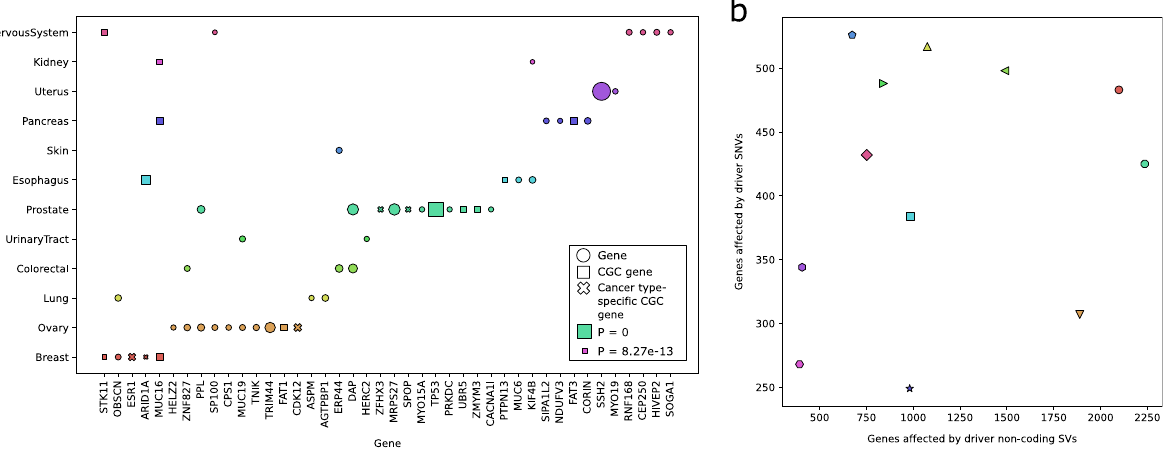
Figure 2. Analysis of predicted pathogenic non-coding SV pairs. (a) Genes affected by pathogenic non-coding SVs as identified by svMIL2 with significant driver potential (showing top 50 most significant gene-cancer type pairs). To determine significant driver potential, random gene sets were sampled 10,000 times with the same size as the number of genes with candidate pathogenic non-coding SVs. A t-test was used to compute which of the candidate genes have more driver coding SNVs (snpEff moderate or high impact, filtered for consensus genes driven by SNVs from IntOGen) than expected by random chance. (b) Comparison of the number of genes affected by pathogenic non-coding SVs with the number of genes affected by driver SNVs reveals a preference for a different driving mechanism per cancer The number of pathogenic non‑coding SVs varies between cancer types. The highest number of pathogenic non-coding SVs is detected in breast, ovarian and prostate cancer, while only low numbers are identified in uterus and kidney cancer (Fig S4c, Table S2). Although the number of pathogenic non-coding SVs increases with the total number of SVs detected within a cancer type, uterus, nervous system and ovarian cancer have more pathogenic non-coding SVs relative to their total SV count (Fig S4d, Table S2). However, there does not appear to be a clear preference for specific SV types in any cancer type (Fig S7). To determine if certain cancer types may be largely driven by non-coding SVs, we plotted the number of genes affected by at least one predicted pathogenic non-coding SV to the genes with driver SNVs from snpEff and IntOGen as detailed above (Fig 2b). Ovarian and pancreatic cancer stand out as having relatively more pathogenic non-coding SVs than driver SNVs. As tumorigenesis is known to be driven by copy number alterations in these cancer types 48–50 , these findings indicate that many of these events may exert driving effects through disrupting TAD boundaries.